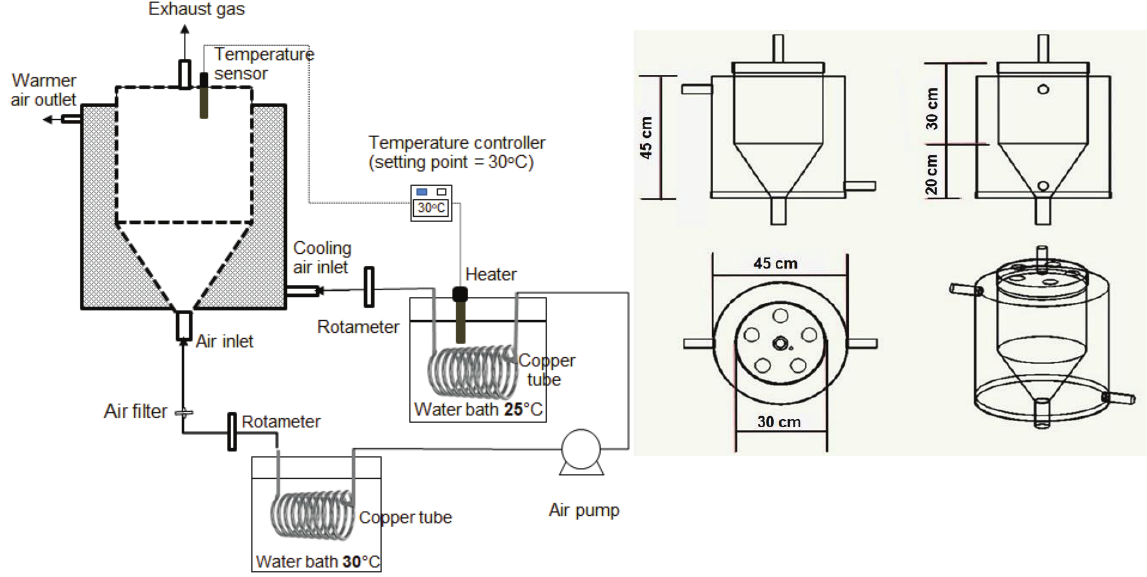
Fig. 2 – Design of air-jacketed packed bed bioreactor (a) Air-jacketed packed bed bioreactor (b) SSF system using air-jacketed packed bed